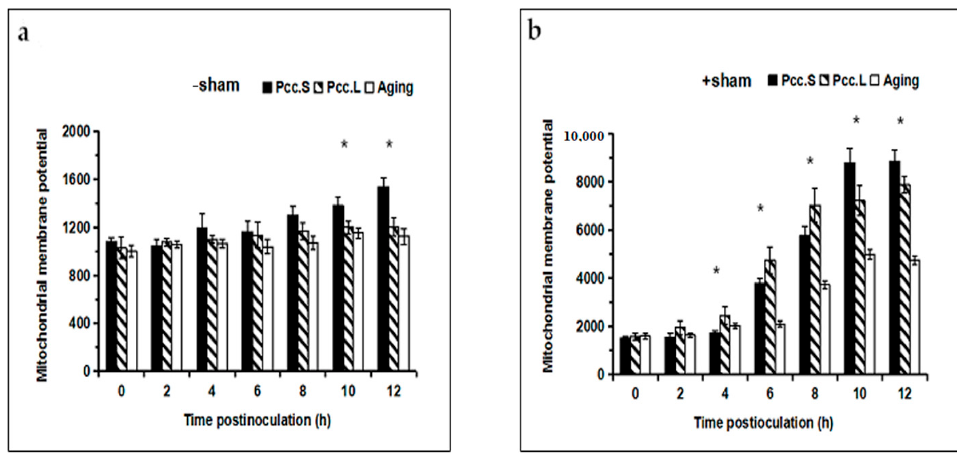
Figure 2. The effect of Pcc .L and Pcc .S treatments on mitochondrial membrane potential of tuber slices in the no salicylhydroxamic acid treated group ( a ) and that of the salicylhydroxamic acid pretreated group ( b ). Aging indicates naturally aged potato tuber slices as control. Bars with * ( t -test) were significantly different at p < 0.05 between Pcc .S and Pcc .L. The standard errors (Vertical bars) of three replicates are shown.